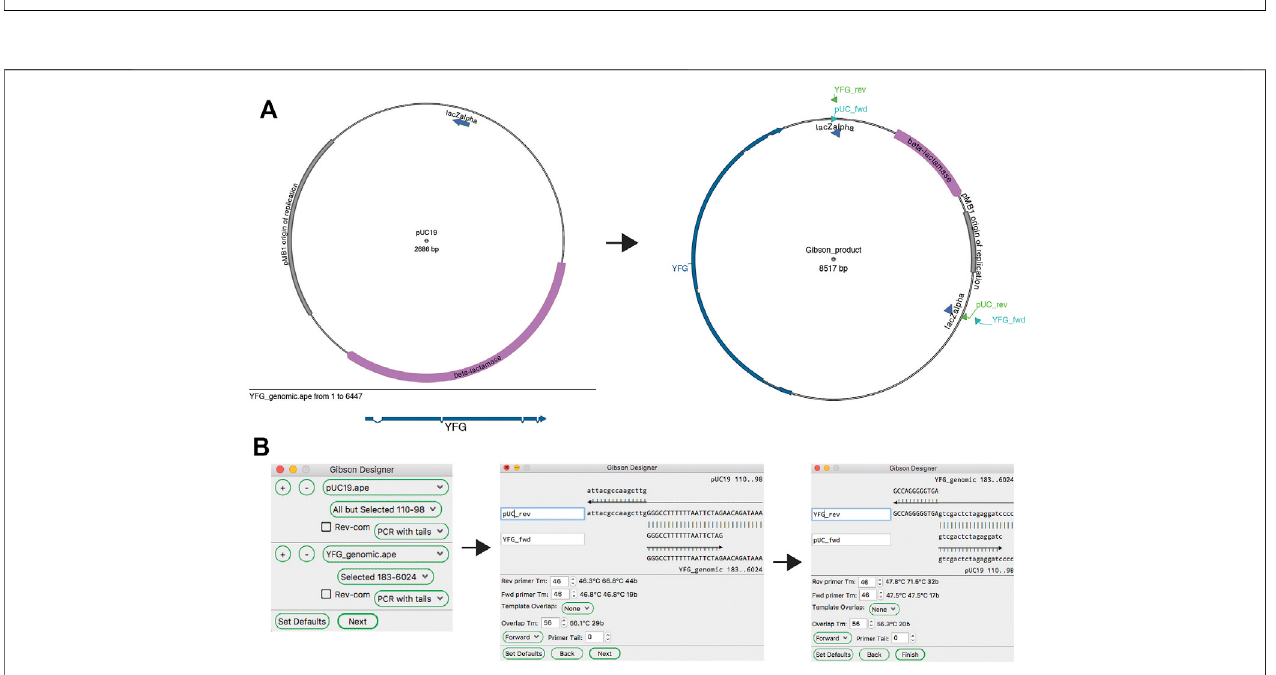
FIGURE 7 | The Gibson Designer tool. (A) Graphic maps of the two input sequences (left) and the output sequence (right). (B) The Gibson Designer is used to specify two PCR products containing YFG and pUC19. The tool then steps through both Gibson junctions, allowing fi ne-grained design of each. Finally, the tool generates the sequence shown on the right in (A)